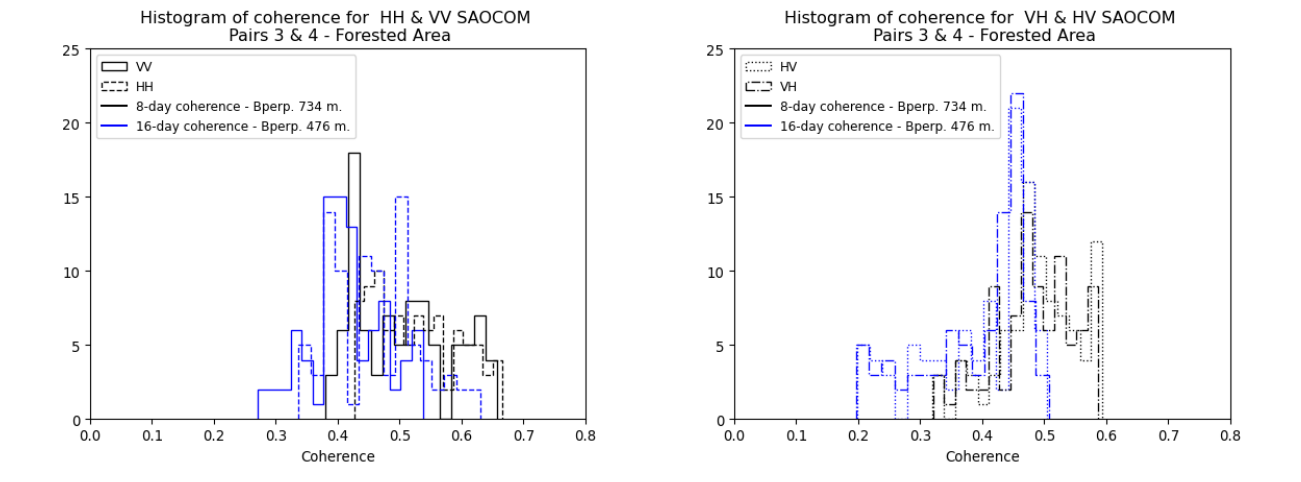
Figure 18. Histograms of | γ | for SAOCOM-1 at 8 and 16 days separation in region A, Figure